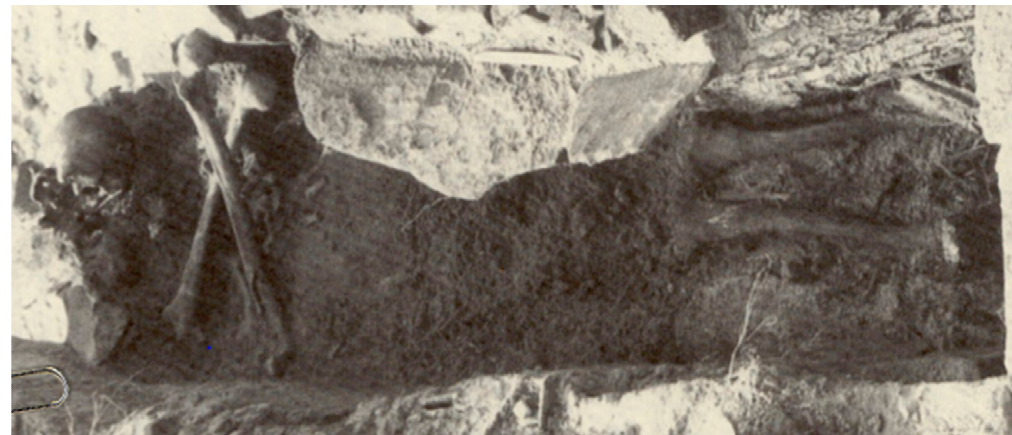
Figure 1. Photograph of JB55 showing the long bones arranged in an “X” directly under the skull in a “skull and cross bones” orientation.